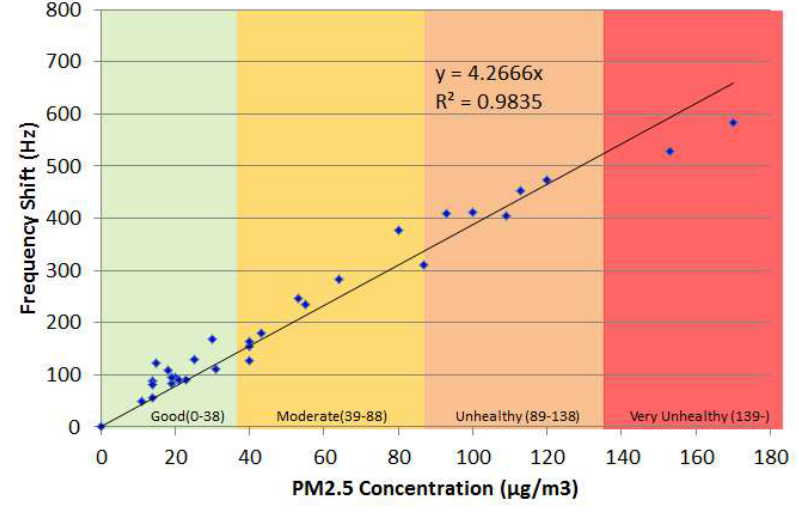
Figure 8. Frequency response of SH-SAW sensor to varied PM2.5 concentration.